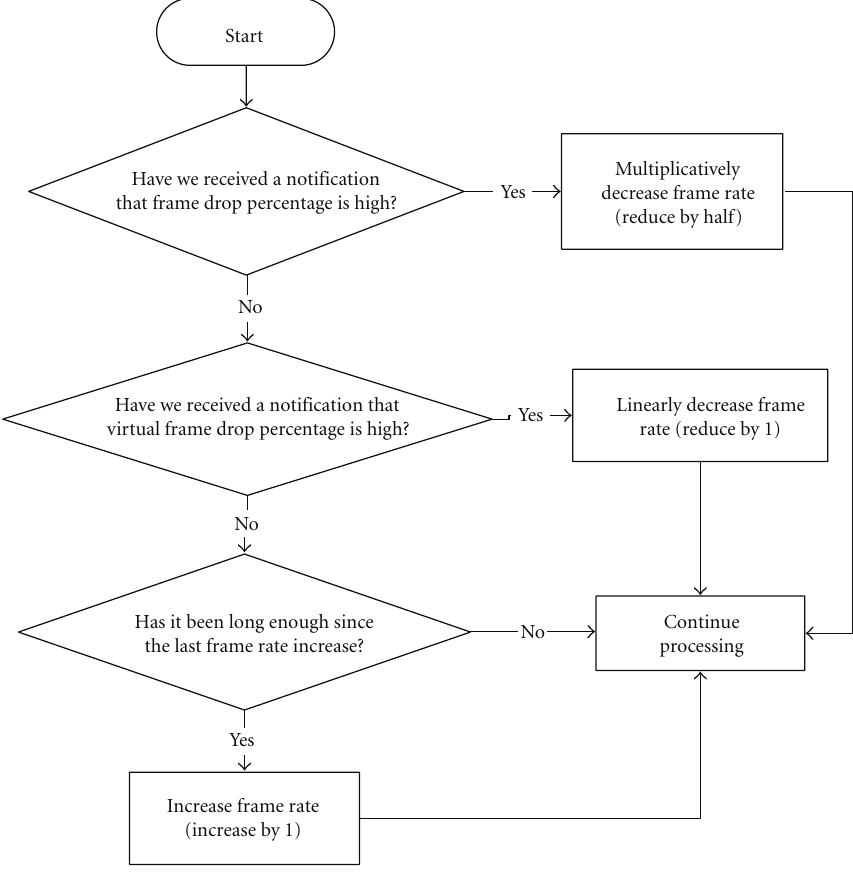
Figure 6: The adaptive frame rate algorithm (sending machine).